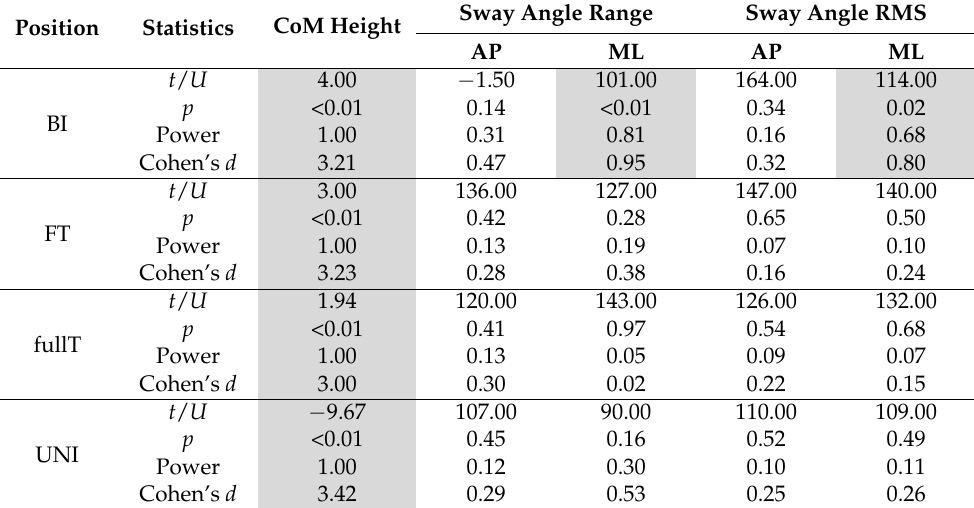
Table 3. Statistic results, power and effect size of the CoM height measured with the kinematic (K_CoM), as well as the Sway Angle Range and Root Mean Square (RMS) value, when compared to the Equimetrix ( E _ CoM ) measurement. Parametric data is expressed as Mean ± Standard-deviation, while non-parametric data is express as Median (Inter-quartile range). Sway Angle Position Statistics CoM Height